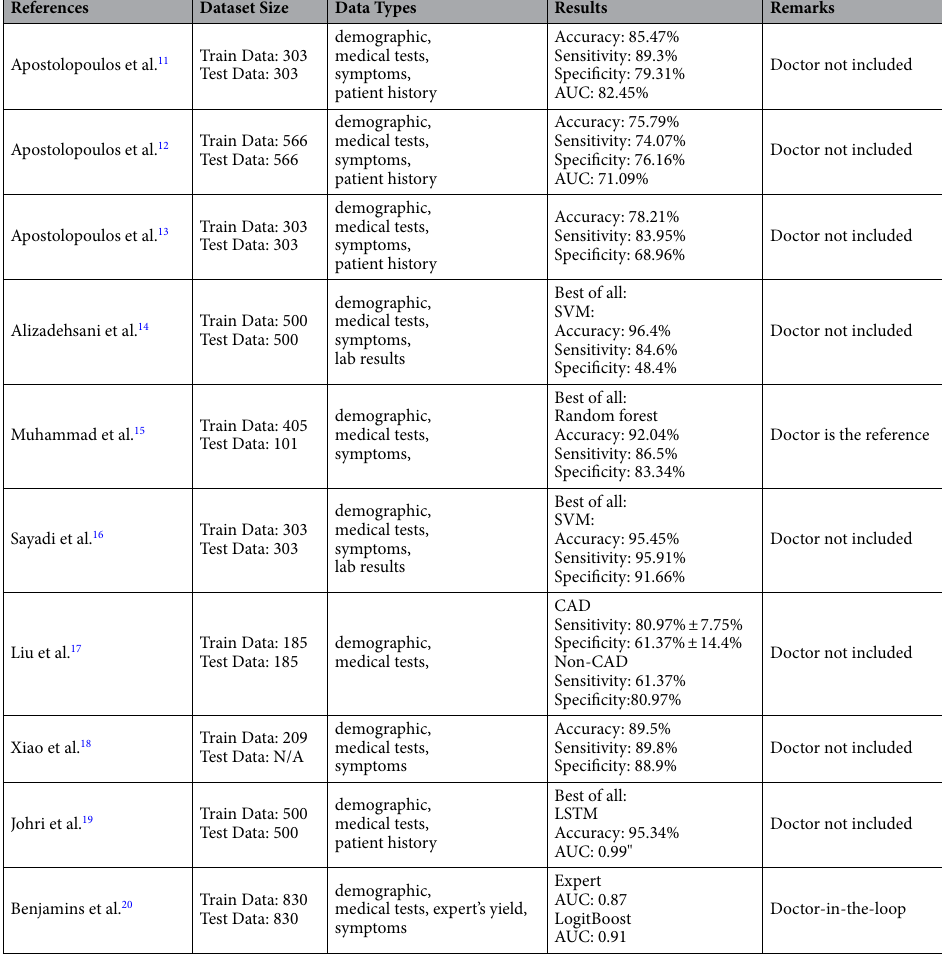
Table 1. Related Work on CAD classification using clinical